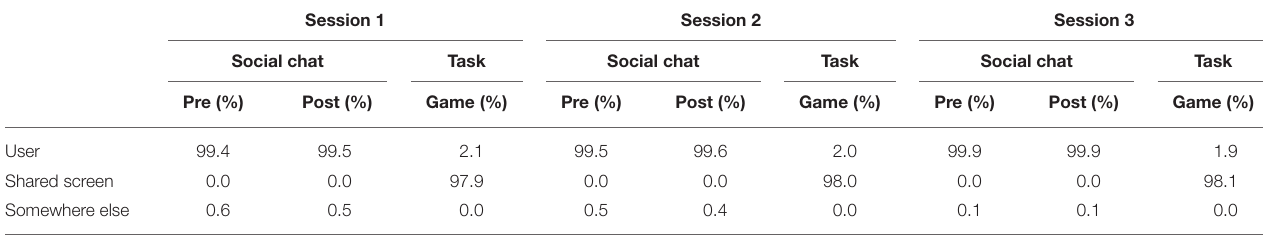
TABLE 1 | The distribution of Furhat’s gaze between the human dialog partner, the shared screen and elsewhere, divided by interaction session, and the task-based (game) and social chat (pre- and post-game dialogue). Session 1 Session 2